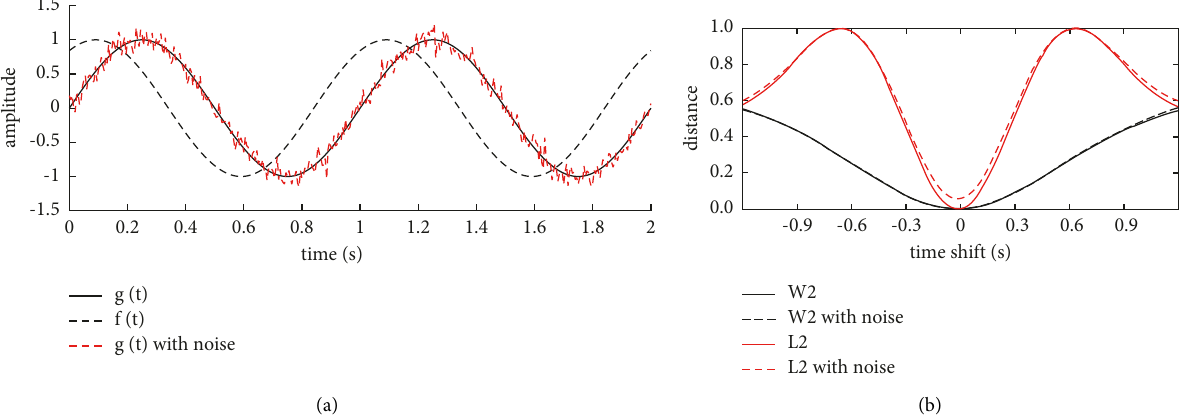
Figure 3: Comparison of the insensitivity to noise of the L2-norm and W2-norm. (a) Synthetic waveform: ft , observed waveform: gt , and observed data plus uniform random noise: gt +noise; (b) the distance between ft and gt and between ft and gt +noise under L2-norm and